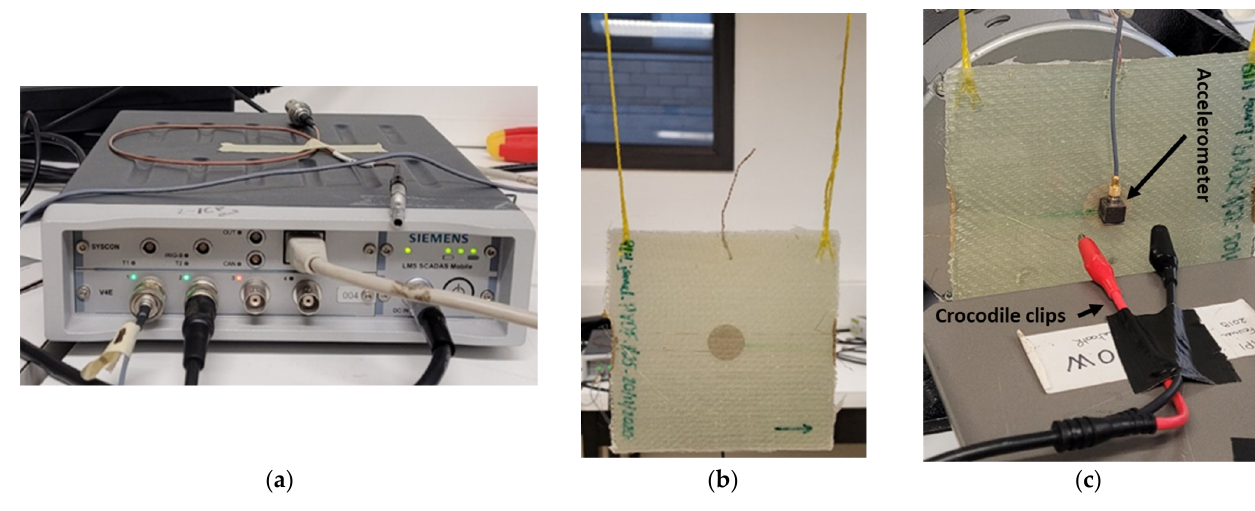
Figure 4. (a) Signal analyzer, (b) suspended plate, (c) crocodile clips and accelerometer.